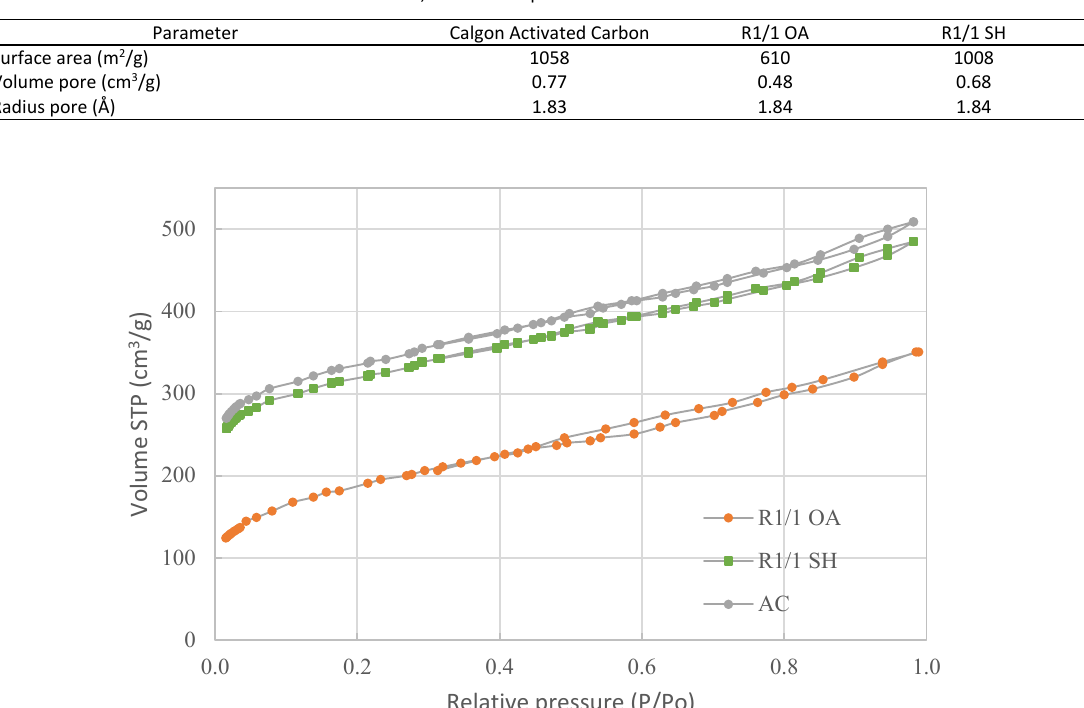
Fig. 9: N adsorption-desorption isotherms of activated carbon and 2